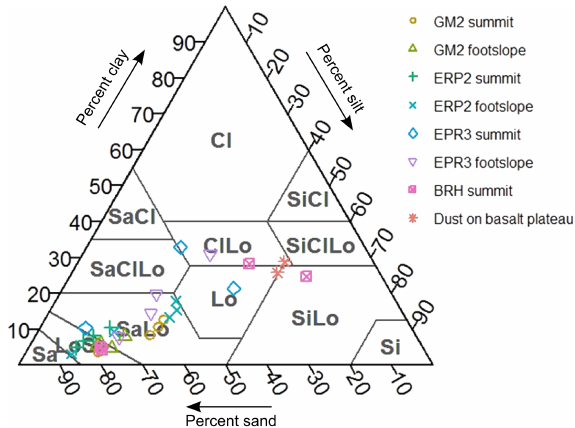
Figure 7. Particle size ternary plots and textural classes for the <2mm fraction of A and B horizons of the studied soils.